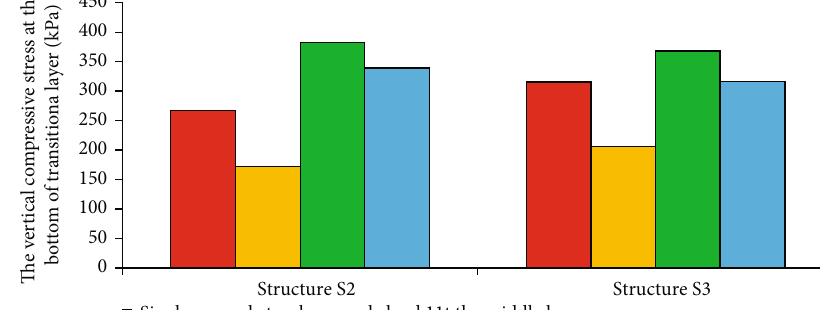
(c) The vertical compressive stress at the top of subgrade